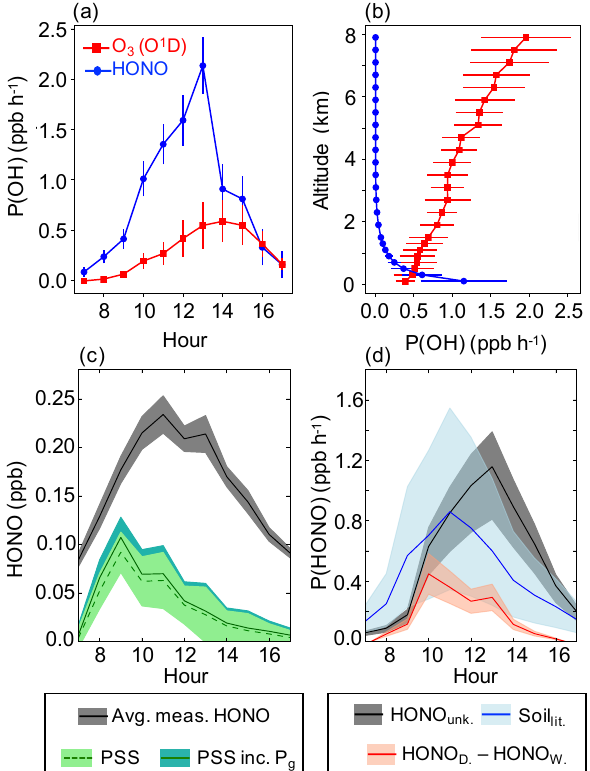
Figure 9. (a) Diurnal cycle of ground level OH radical production P (OH) from ozone (O 3 to O( 1 D)) and HONO photolysis, calculated for an example day with 27ppb surface ozone, and the HONO diur- nal cycle from 7 March 2018 which peaked near midday at around 400ppt. (b) Vertical profiles of tropospheric OH radical produc- tion from HONO photolysis, calculated using the average measured HONO vertical profile and from ozone photolysis calculated us- ing co-located ozone sonde data averaged from January to April 2018. Points represent the mean; error bars represent 1 standard deviation. (c) Measured average HONO diurnal cycle plotted with the calculated photostationary state (PSS) HONO concentration and PSS including the NO 2 ground conversion term (PSS including P g ). (d) HONO unk . is the unknown HONO production rate (measured minus PSS), HONO D − HONO W is the measured HONO emission rate attributable to soil processes (driest conditions minus wettest conditions, see Fig. 11 and discussion in Sect. 3.5), and Soil lit rep- resents PSS and literature HONO and NO soil emission rates. Lines represent means; shaded regions represent 95% confidence inter-